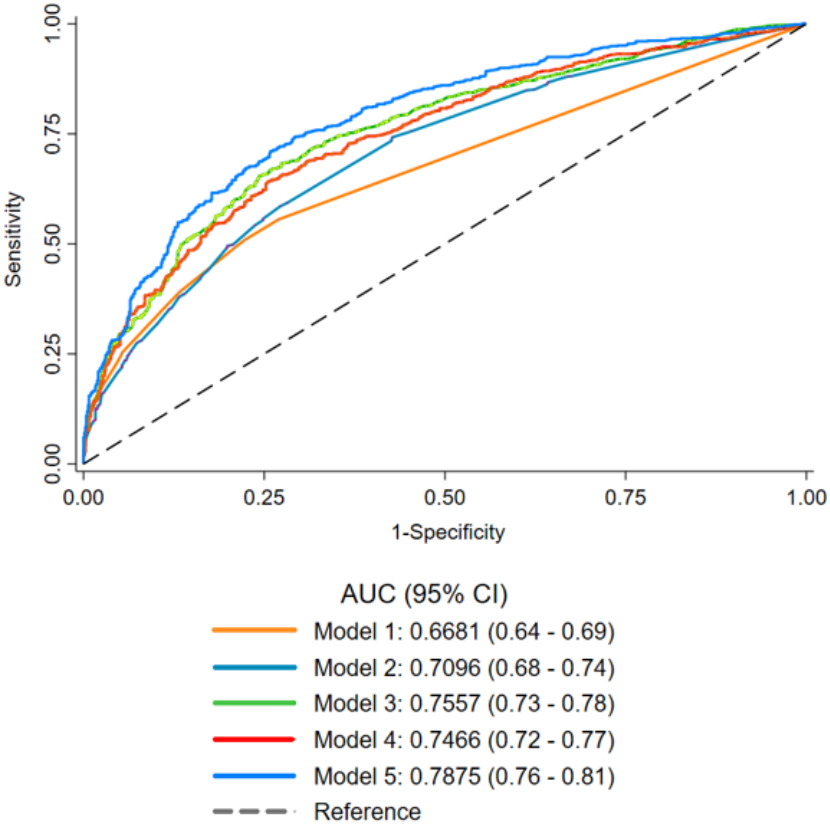
Figure 3. Area under the ROC curves (AUC) for five different predictive models of micronutrient deficiency showing discriminative ability (chi-square test p ≤